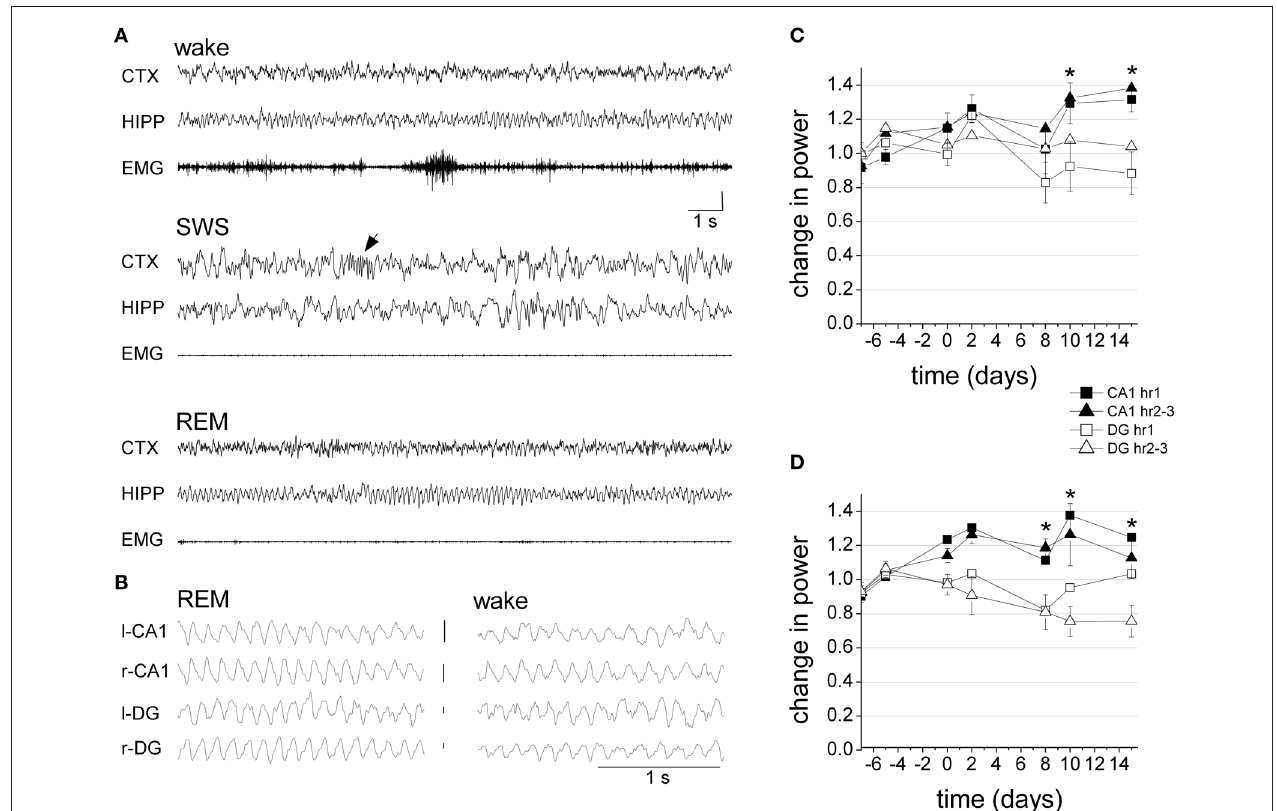
FiguRE 4 | Hippocampal oscillations after picrotoxin injection in BLA in freely behaving rats. (A) Specimen recordings of frontal cortical (CTX) and hippocampal (HIPP) EEG and muscle activity (EMG) in different sleep-wake states, 8 day after injection (SWS – slow wave sleep, arrow: sleep spindle). (B) Field potentials at the major theta dipoles. Note phase ( ∼ 180 deg) and amplitude (DG > CA1) difference (EEG calibration 1 mV). (C,D) Average theta (C) and gamma (D) power during the 1st hour and hours 2–3 of seven recording